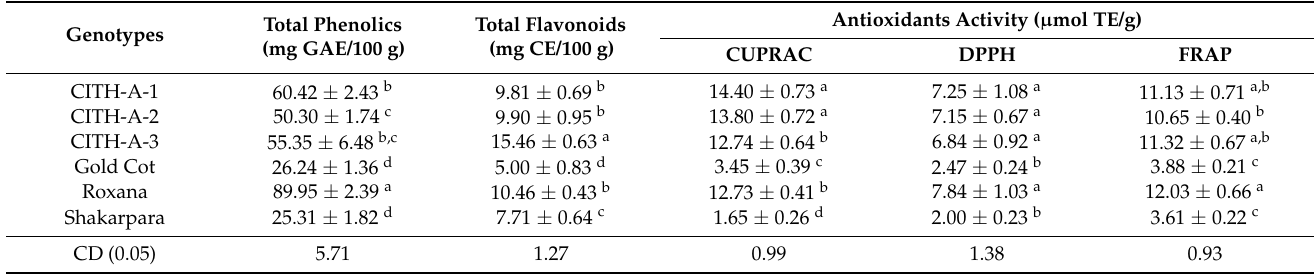
Table 5. Variation in total phenolics, flavonoid, and antioxidant activity in different apricot genotypes.